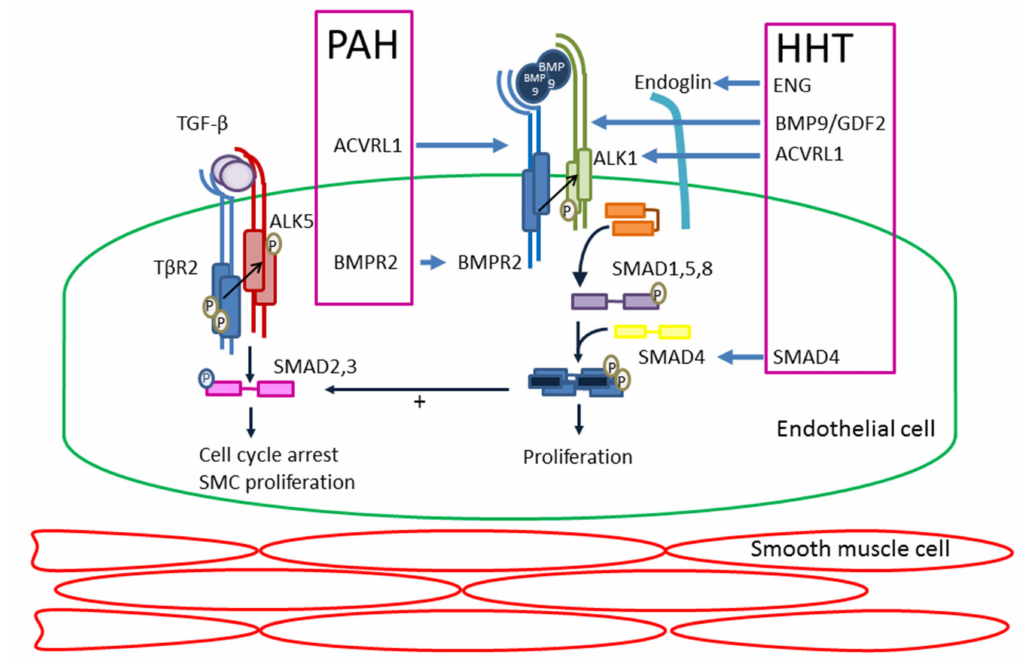
Figure 1. Schematic diagram illustrating the transforming growth factor-beta (TGF- β ) pathway and the genes and proteins involved in pulmonary arterial hypertension (PAH) and hereditary haemorrhagic telangiectasia (HHT). Illustrated are two pathways of ALK5/SMAD2-3 and ALK1/SMAD1-5. SMC, smooth muscle cell. P,